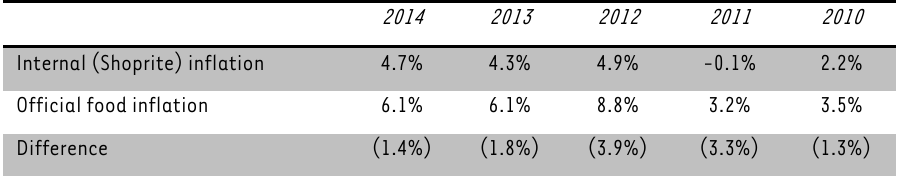
TABLE 12: Shoprite internal inflation versus official food inflation from 2010 to